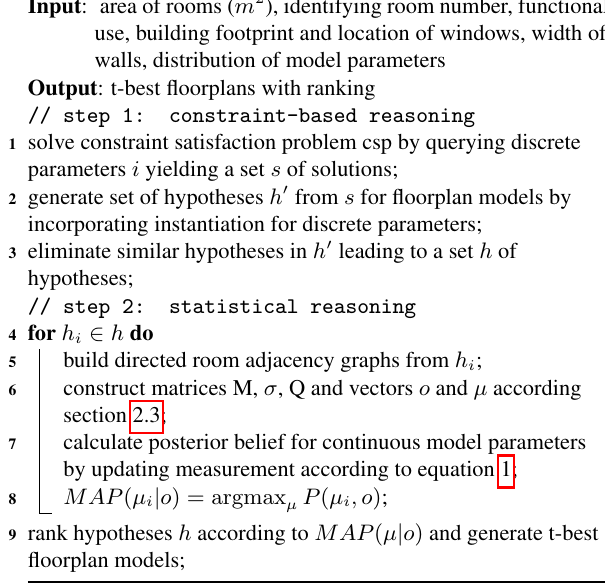
Algorithm 1: algorithm for prediction of most probable floor-